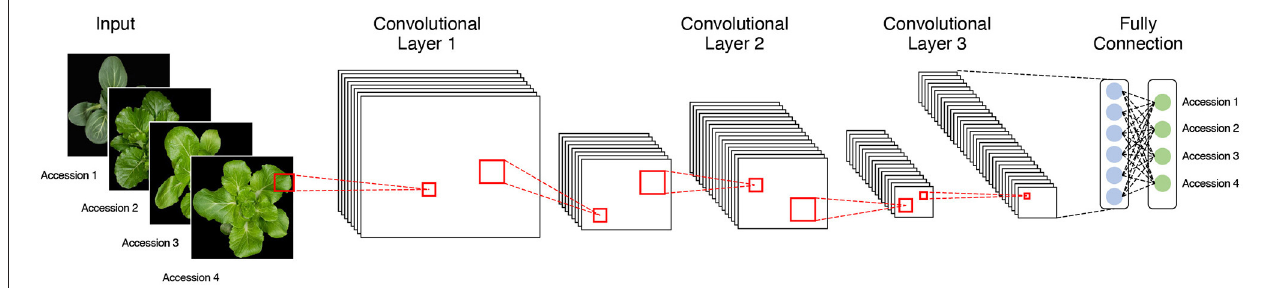
FIGURE 3 | The basic structure of a convolutional neural network (CNN) analysis with image data as input. The classification model is composed of multiple convolution and pooling layers.